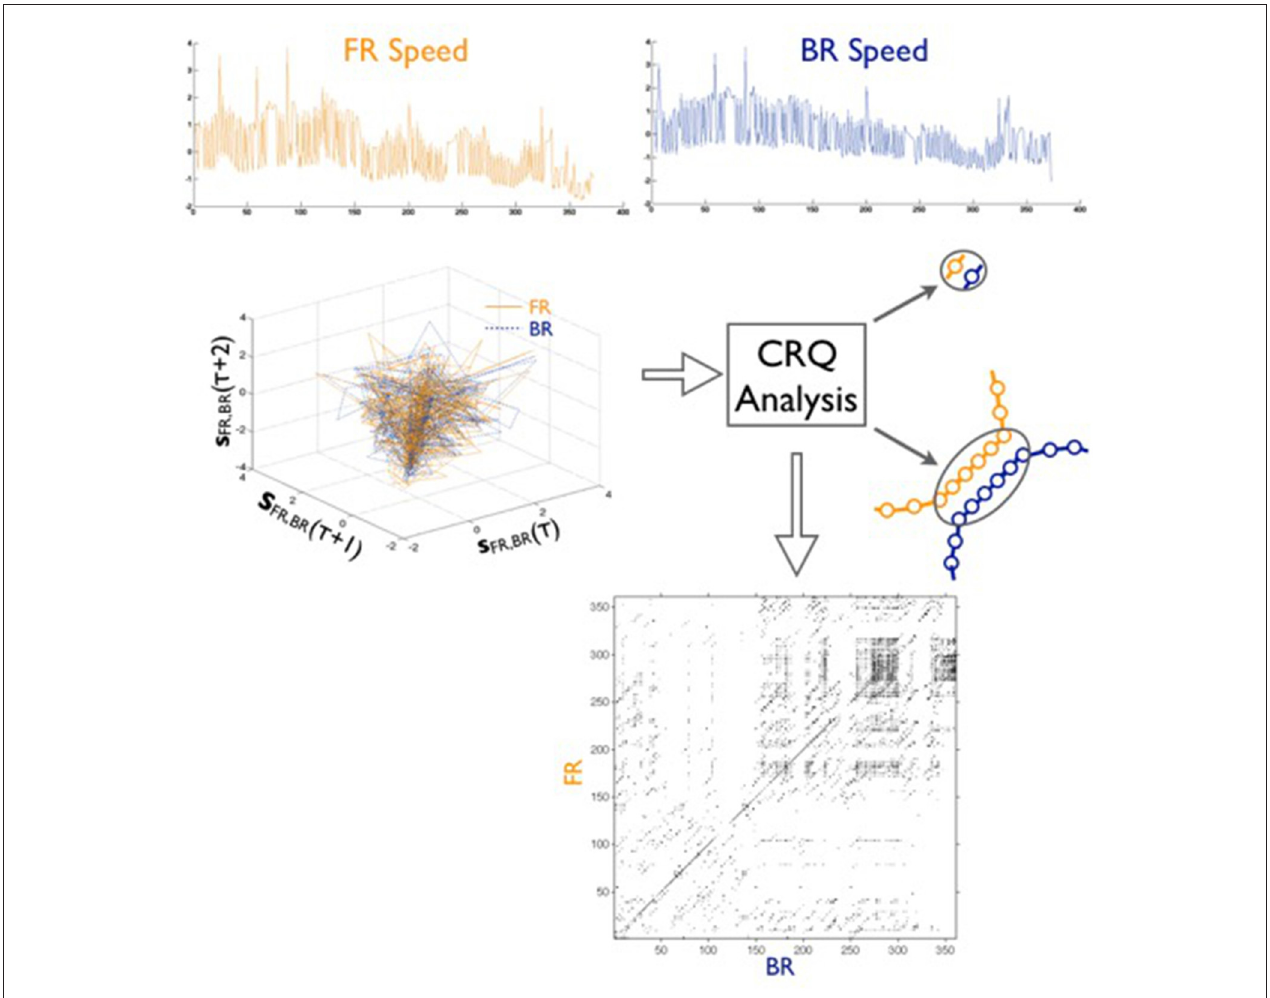
FIGURE 2 | A schematic of the steps in the CRQ analysis. For each trial, the speed time series of one agent (FR = top left) and a second agent (BR = top right) are unfolded separately into a shared reconstructed phase space via time-delayed copies of each measured time series, denoted as s FR,BR (center, left). Recurrent points within a given radius and strings of recurrent points are identified with respect to each point in phase space and represented in a cross-recurrence plot (center, right), in which each axis represents the s FR and s BR time series at each time step. Each pixel indicates a recurrent point on a recurrence plot (bottom), and the diagonal line structures indicate the length of a string of recurrent points, or the co-evolution of the two time series at different time delays. The longest diagonal line, cross-maxline (CML), was computed for each dyad in the group.